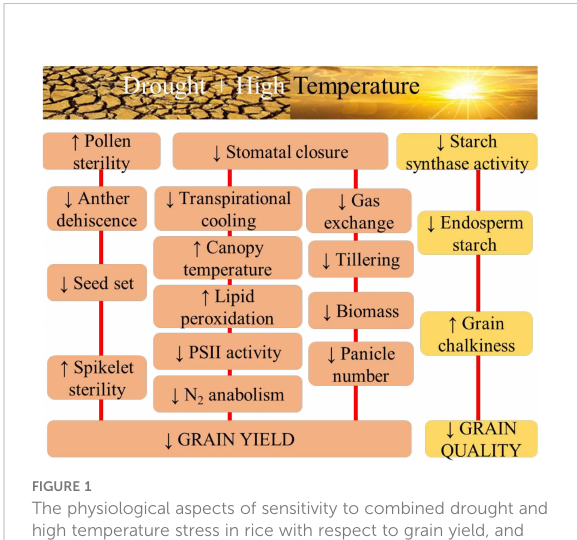
FIGURE 1 The physiological aspects of sensitivity to combined drought and high temperature stress in rice with respect to grain yield, and